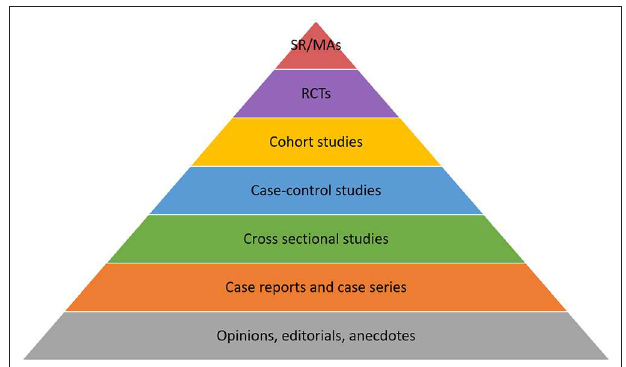
FIGURE 5 | Pyramid of evidence, modified from Phillips (53). SR, Systematic reviews; MA, Meta-analysis; RCTs, Randomised controlled